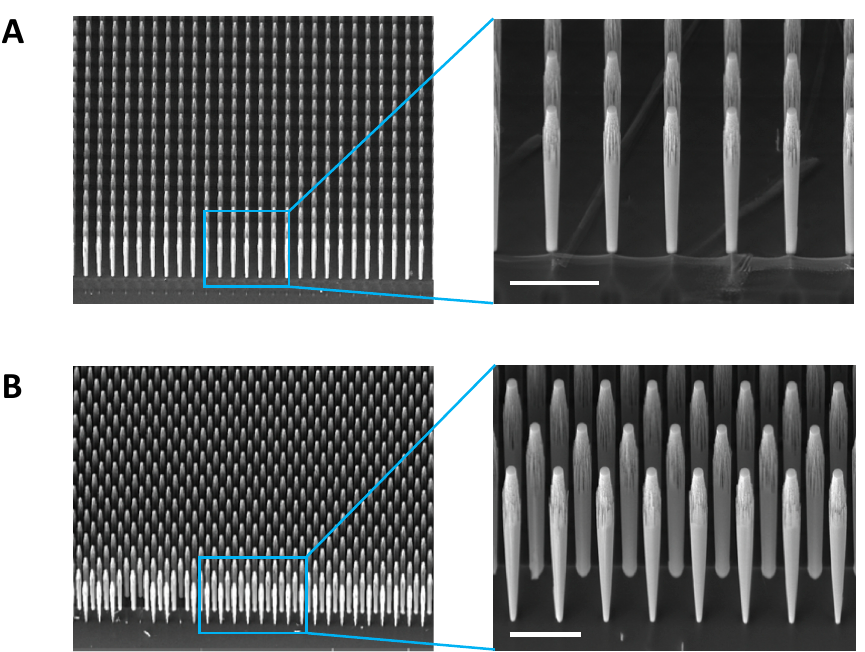
Figure 2. Silicon micropillars can be arranged with different topographies. Silicon micropillar arrays are perfectly vertically-aligned with a height that can be tuned in a 200–600 µm range. Specific spacing, density and morphology of the silicon pillars can be arranged by changing the mask of lithographic process. Low and high magnification of cross-sectional SEM images of aligned ( A ) and staggered ( B ) micropillar arrays. Scale bar: 50 µm.